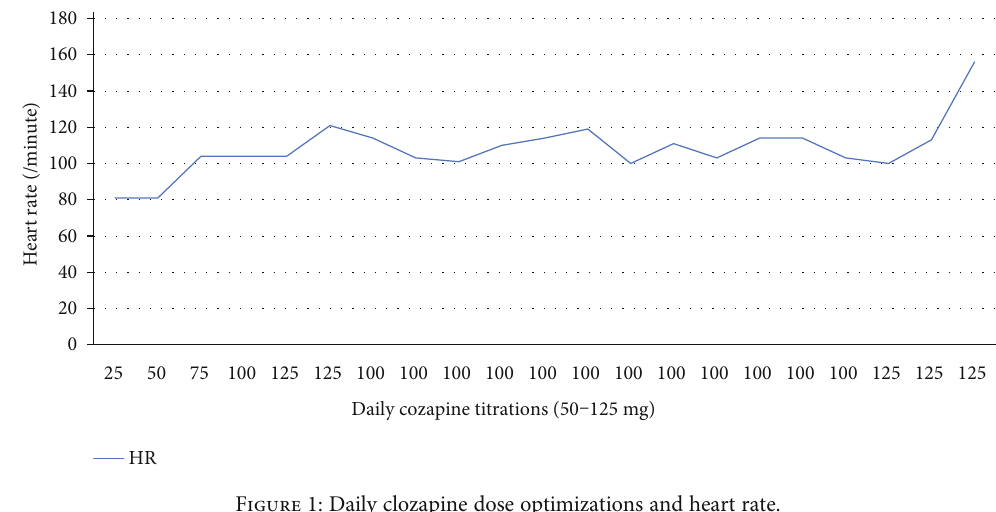
Figure 1: Daily clozapine dose optimizations and heart rate.